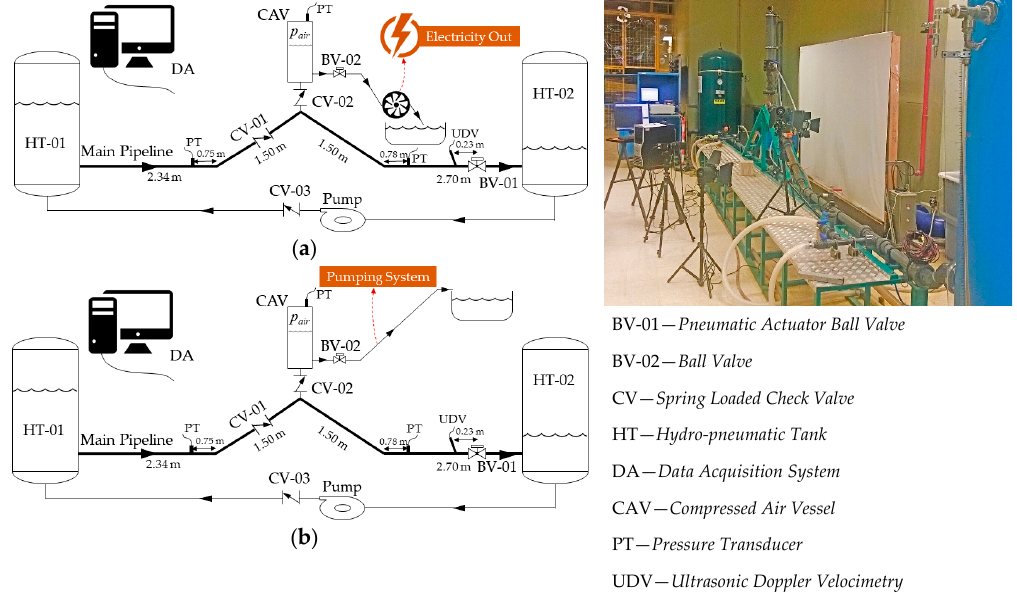
Figure 2. Experimental apparatus as part of the transient flow-induced compressed air energy storage (TI-CAES) system and energy conceptual ideas: ( a ) electricity dispatch; ( b ) pumping